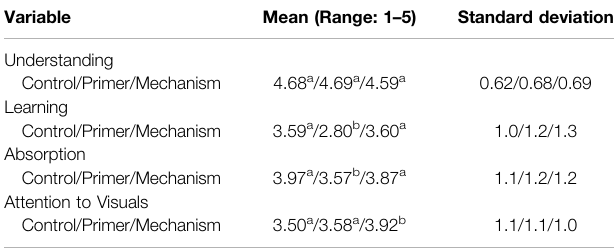
TABLE 1 | Mean values of courses for Understanding, Learning, and Absorption.